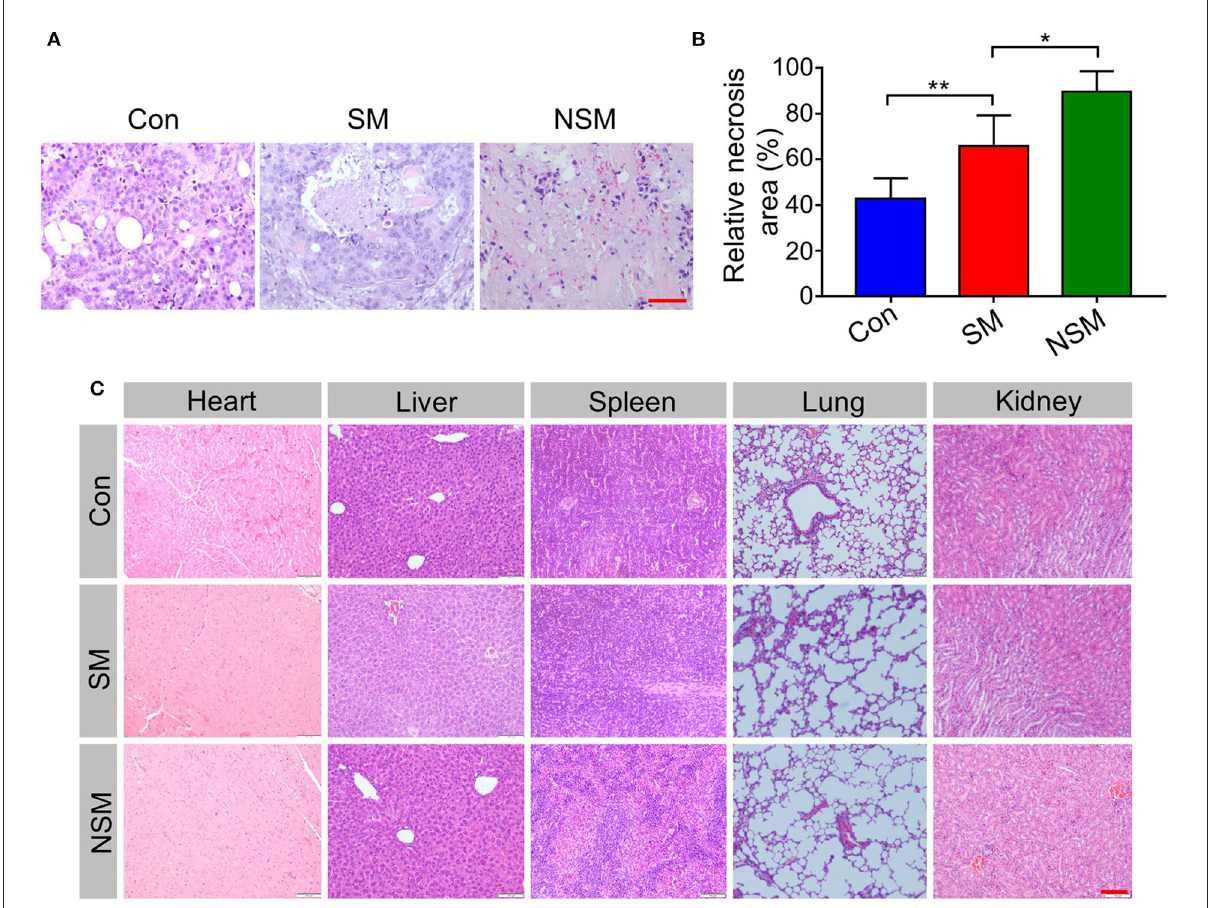
FIGURE6 Histopathological analysis. (A) H&E staining and (B) relative necrosis area of tumor tissues. (C) H&E analysis of major organs. Scale bars = 100 µ m. * and ** represent P < 0.05 and P < 0.01,